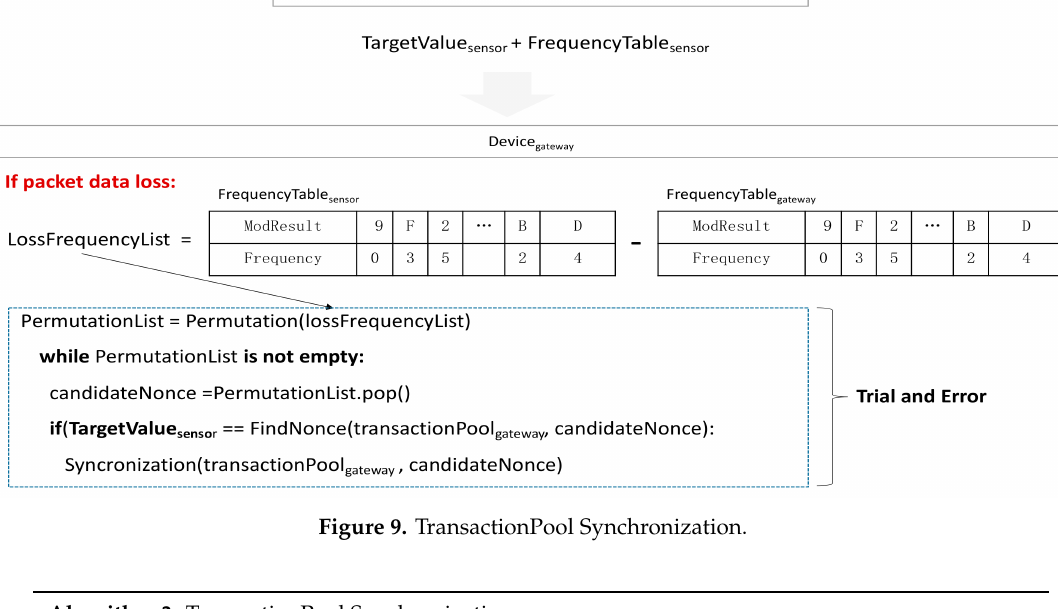
Algorithm 3. TransactionPool